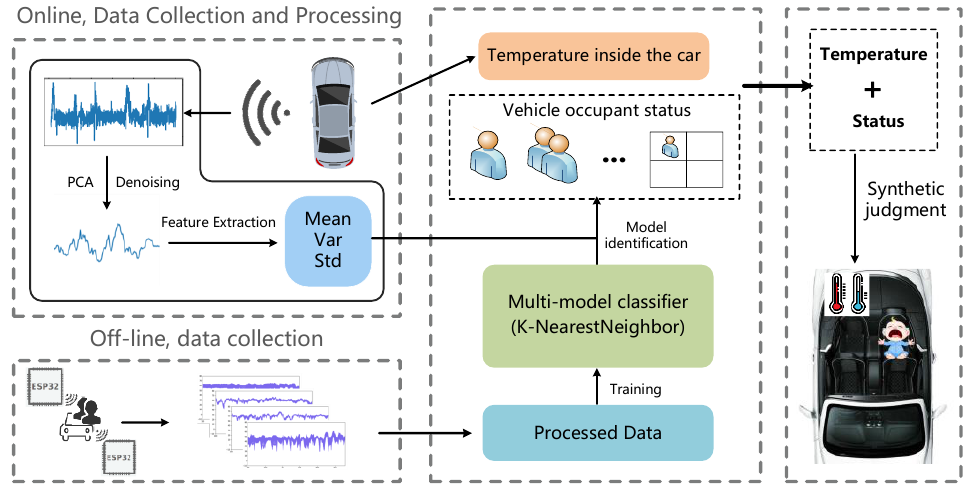
Figure 4. Car-Sense Overview.